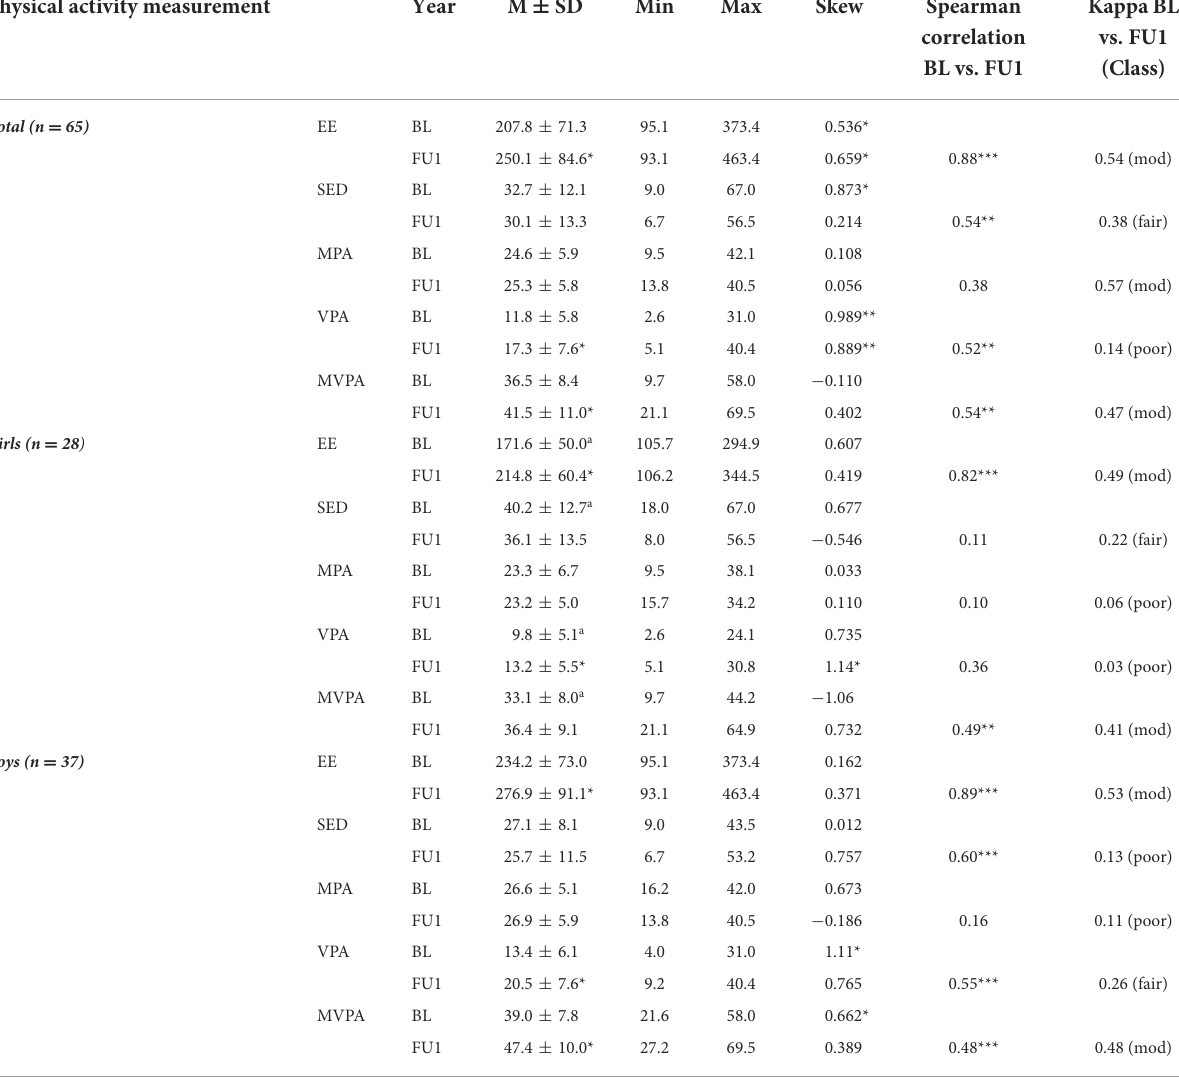
TABLE 2 Means and standard deviations (M ± SD), minimum, maximum, Shapiro-Wilk skewness, correlation coefficients, kappa statistics, and classifications for the physical activity measures obtained during a summer day camp program that included guided active play sessions (55min) at baseline (BL) and 1-year later